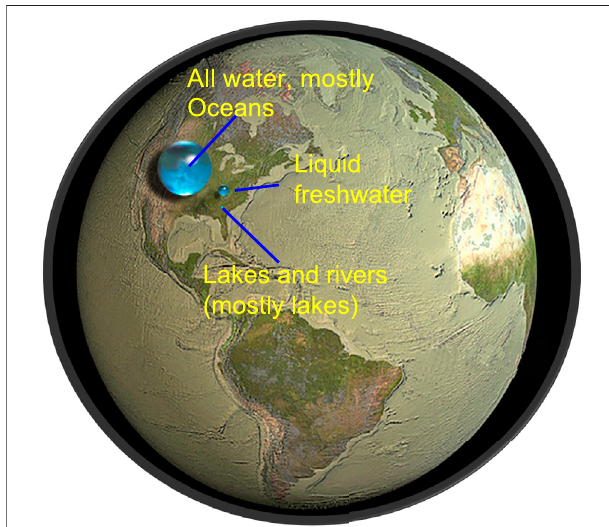
FIGURE 1 | How water is distributed on Earth. The tiny pixel over Georgia represents all surface freshwater lakes and rivers. Illustration after USGS depiction by Perlman, Cook and Nieman who used the data of Shiklomanov (1993). https://water.usgs.gov/edu/gallery/global-water- volume.html.